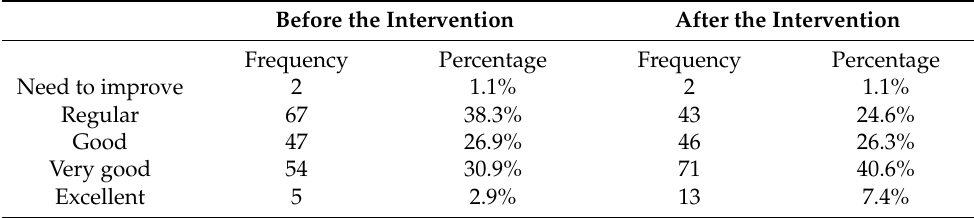
Table 1. Classification of the lifestyle of the elderly before and after the intervention project.